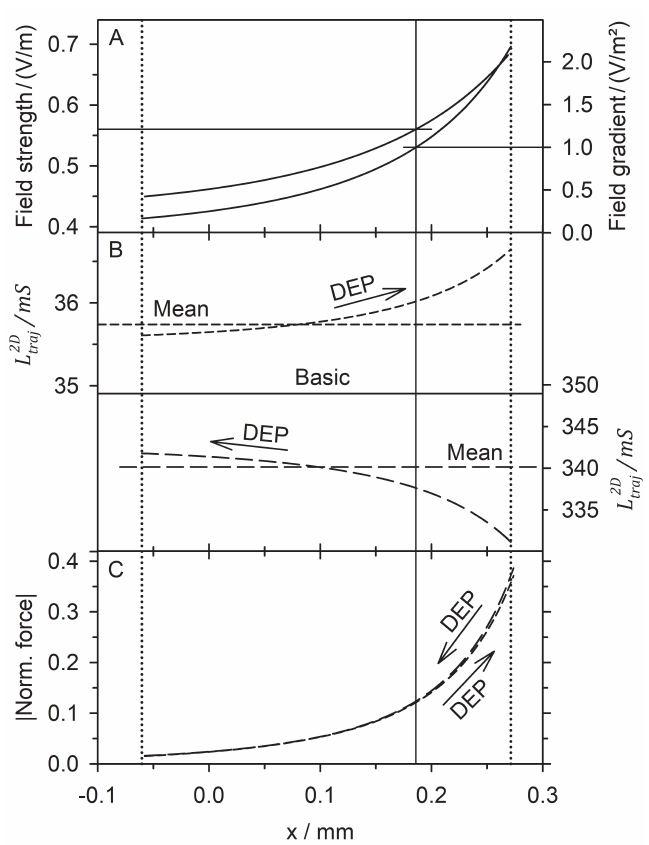
Figure 8. DEP behavior in the dipole range marked in Figure 2. ( A ) Field strength and field gradient along the symmetry line for 1 V potential difference at the electrodes. The vertical auxiliary line at x = 186 µ m is perpendicular at a field gradient of 1 V/m 2 (field strength of 0.5602 V/m). Horizontal auxiliary lines run out to the respective ordinates from the intersections with field strength and field gradient plots. ( B ) DEP of the sphere increases the overall conductance of the chamber. Top: 1.0 S sphere, 0.1 S medium (short, dashed line, left ordinate, positive DEP), bottom: 0.1 S sphere 1.0 S medium (long dashed line, right ordinate, negative DEP). At x = 186 µ m, the conductances are 36.02 mS and 337.6 mS. The common baseline corresponds to the basic conductances of the two setups. ( C ) At x = 186 µ m, the normalized forces from Equation (16) are 0.1211 (1.0 S sphere, 0.1 S medium) and 0.1234 (0.1 S sphere, 1.0 S